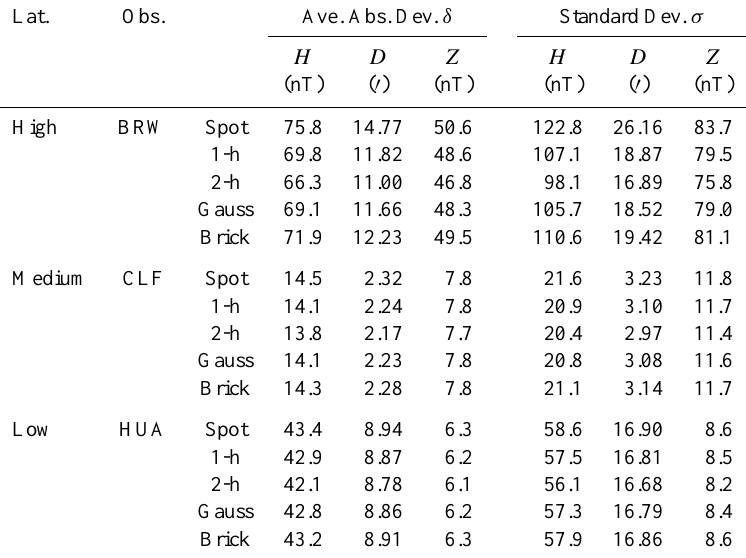
Table 2. Statistics of discrete 64-min “hourly” average-samples for 1998.0–2009.0. Lat.